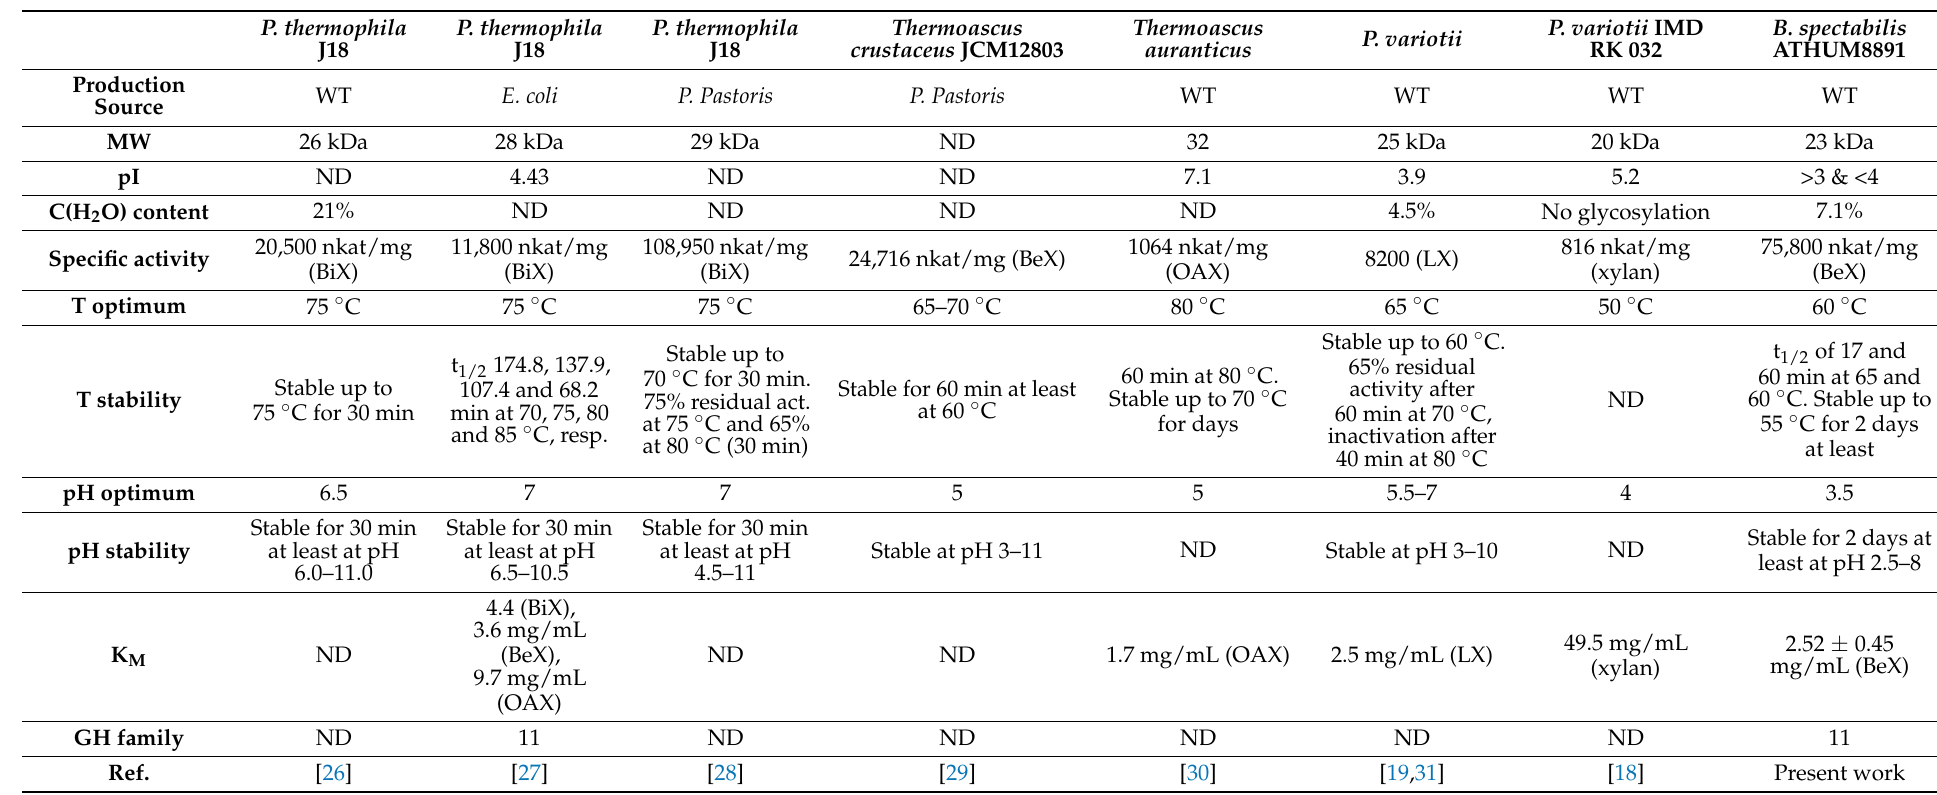
Table 3. Biochemical properties of the characterized xylanases originated from Thermoascaceae